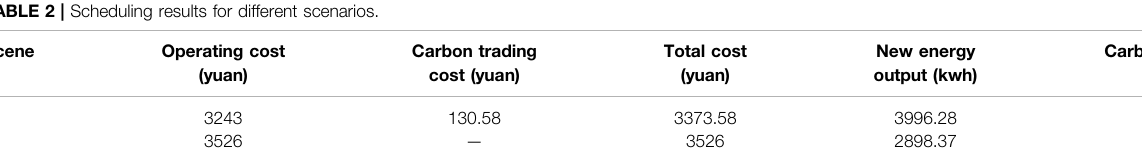
TABLE 2 | Scheduling results for different scenarios.